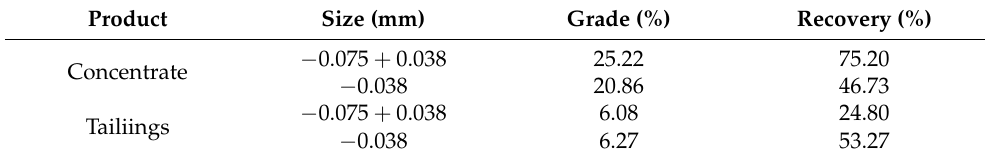
Table 7. The grade and recovery of different particle grades in concentrate and tailings products.